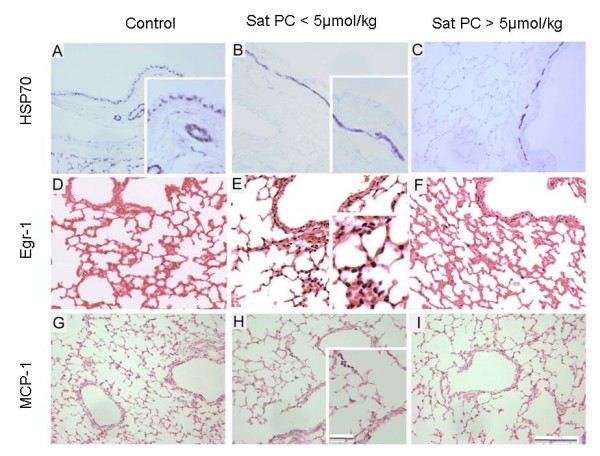
Localization of HSP70 mRNA, Egr-1 protein and MCP-1 protein. HSP70 in situ localization demonstrates signal in bronchial epithelium in controls (A), which is lost in ventilate lambs (B, C). Induction of HSP70 mRNA in smooth muscle surrounding airways is seen in lambs with < 5 μmol/kg Sat PC (B) and lambs with >5 μmol/kg (C). Egr-1 protein is not in airways of control lambs (D) but Egr-1 protein staining is qualitatively increased in lambs ventilated with < 5 μmol/kg Sat PC (E) verses lambs with > 5 μmol/kg (F). Compared to MCP-1 in controls (G), MCP-1 protein is localized to the mesenchyme surrounding the medium sized airways and to the inflammatory cells in lambs ventilated with < 5 μmol/kg Sat PC (H) with minimal staining in animals with > 5 μmol/kg (I). Scale bar = 50 μm, insert 25 μm.